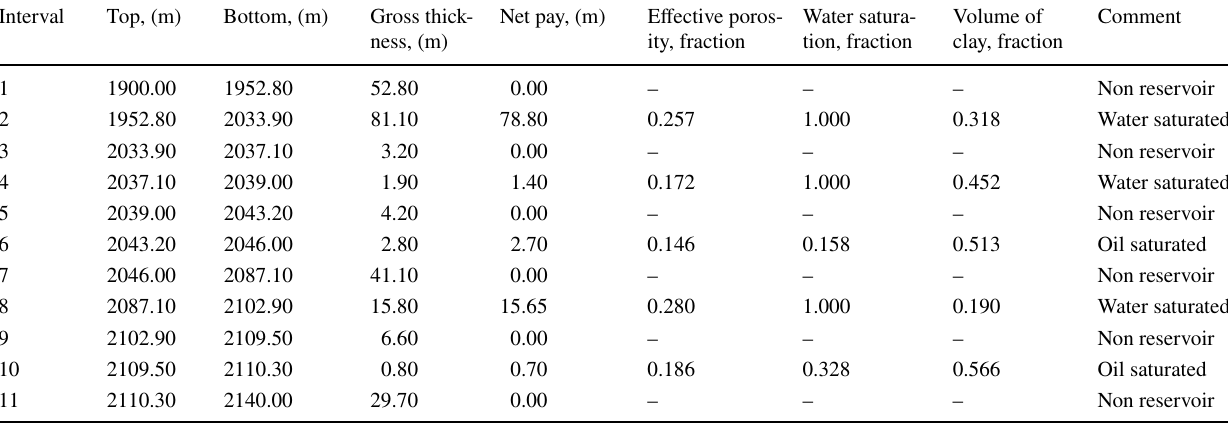
Table 12 Wireline logs interpretation for Lower Eocene deposits of Well # 12 Vorobyevskaya Interval